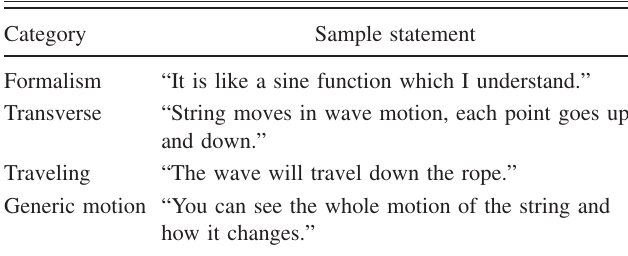
TABLE V. Long answer coding